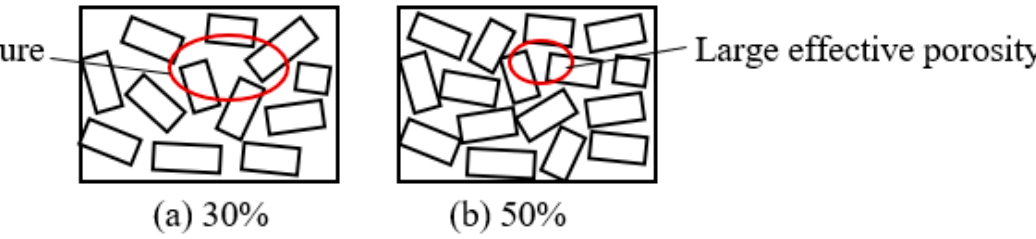
Figure 10. Schematic diagram of the principle behind the sound absorption performance of different hemp stalk mass fractions.